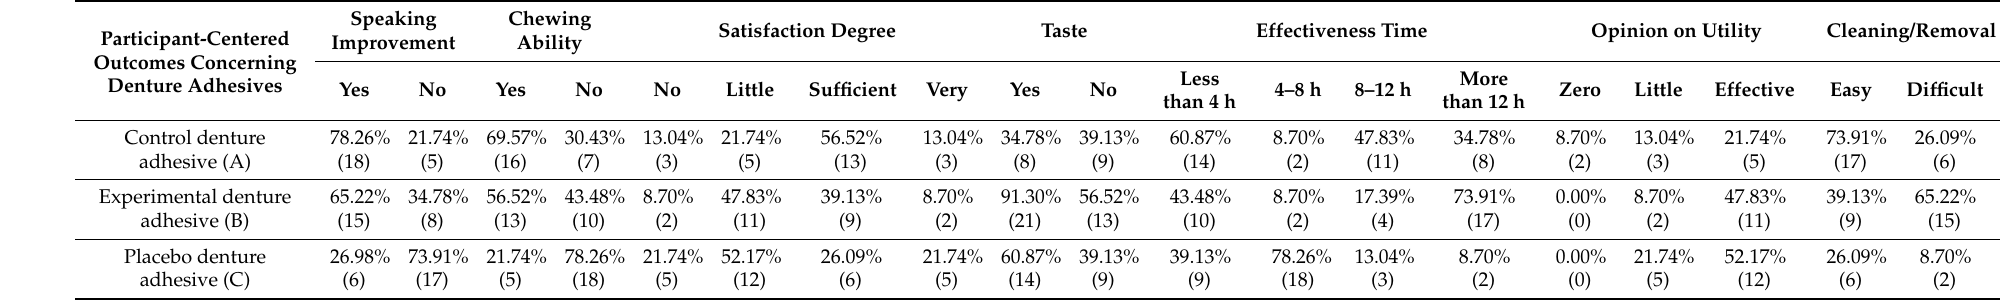
Table 1. Descriptive analysis of the patient-centered outcomes.